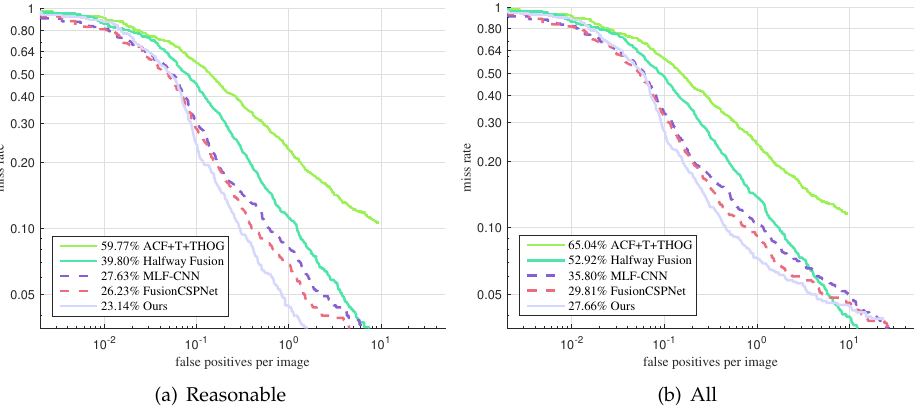
Figure 7. Qualitative comparison of multispectral pedestrian detection results in the KAIST rea- sonable test subset with other state-of-the-art approaches. ( a ) ground truth, ( b ) detection results of YOLOv4 trained by color dataset only, ( c ) detection results of YOLOv4 trained by thermal dataset only, ( d ) detection results of FusionCSPNet trained by multispectral dataset, ( e ) detection results of ours method trained by multispectral dataset. Note that green bounding boxes (BBs) show GT labels, red and blue BBs are detection result, red BBs show TP, blue BBs show FP, and yellow shows FN. Best viewed in color.